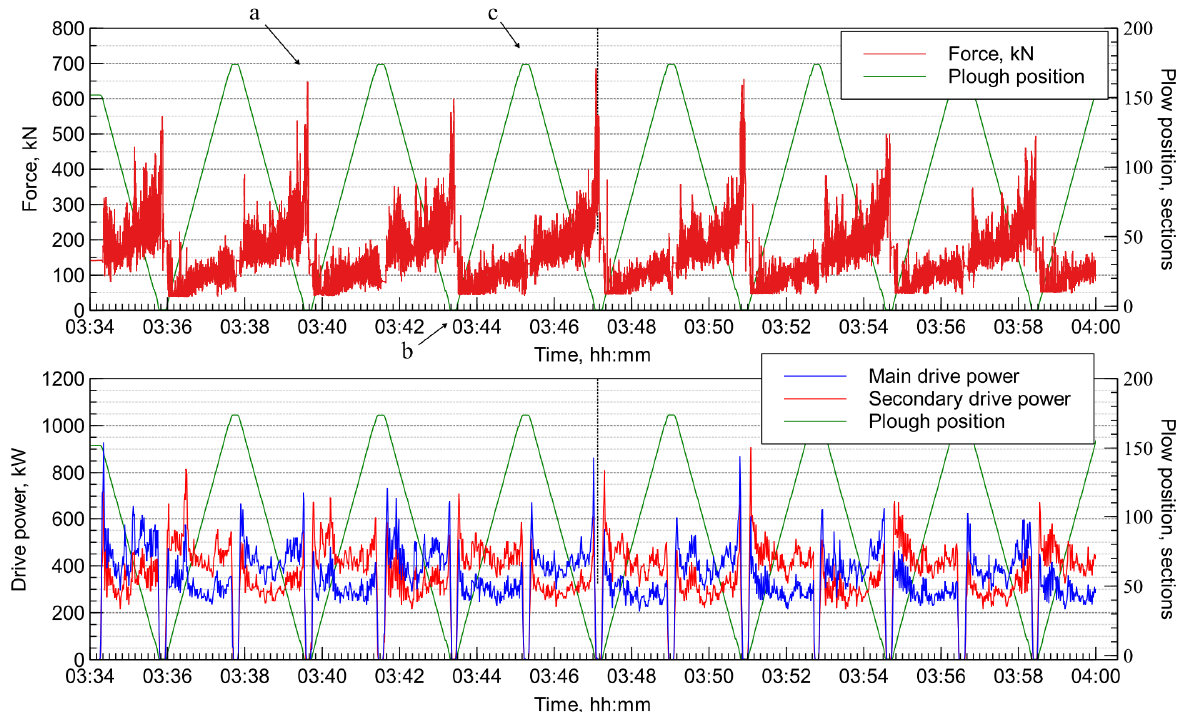
Figure 13. Recorded force measurements and plough system data: main drive side. a—peak in the measured force, b and c—points of changes in the plough travel direction.